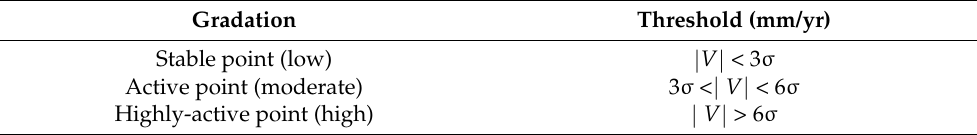
Table 1. The thresholds for deformation velocity